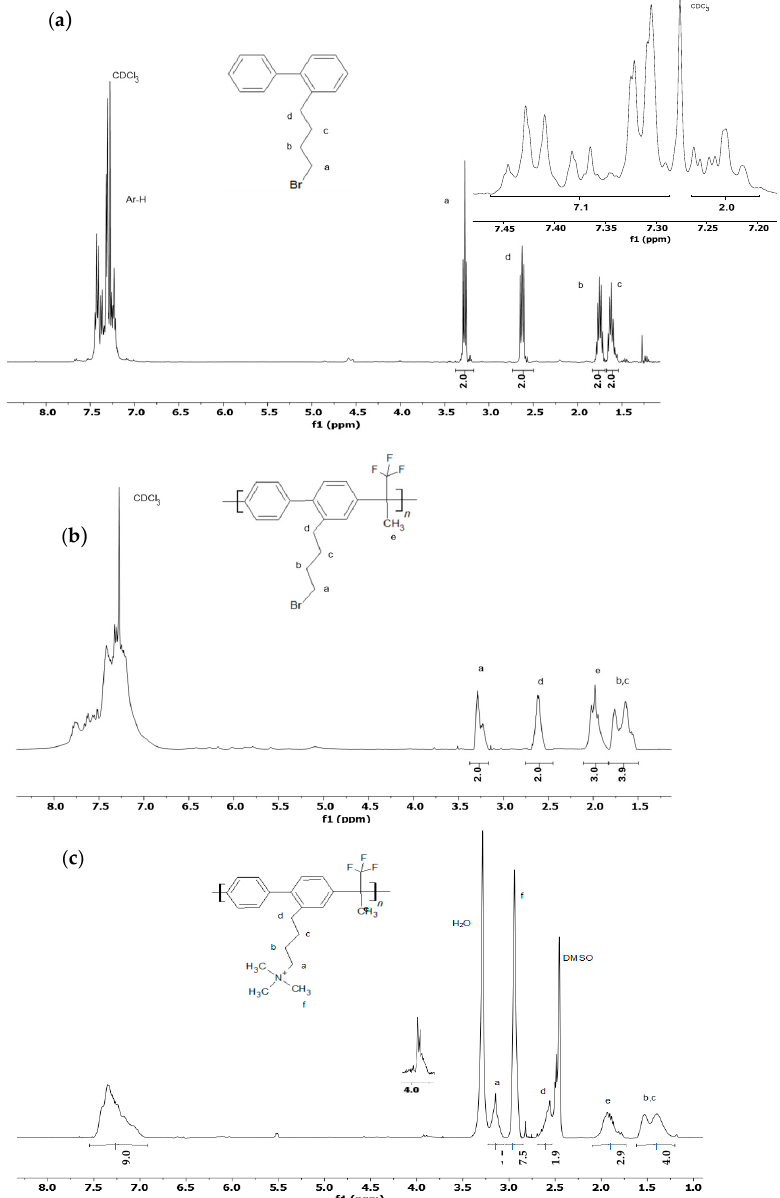
Figure 2. 1 H ‐ NMR analysis of: ( a ) 2 ‐ (4 ‐ bromobutyl)biphenyl ( 2 ) in CDCl 3 ; ( b ) poly[(2 ‐ (4 ‐ bromobu ‐ Figure 2. 1 H-NMR analysis of: ( a ) 2-(4-bromobutyl)biphenyl ( 2 ) in CDCl 3 ; ( b ) poly[(2-(4- tyl)biphenyl ‐ 4,4 ′‐ diyltrifluoromethylmethylmethylene] ( 3 ) in CDCl 3 ; ( c ) PBBAA ( 4 ) in DMSO ‐ d 6 . bromobutyl)biphenyl-4,4 (cid:48) -diyltrifluoromethylmethylmethylene] ( 3 ) in CDCl 3 ; ( c ) PBBAA ( 4 ) in DMSO-d 6 The IEC of the ionomer determined by acid–base titration (IEC = 2.5 meq/g) is in good agreement with the degree of functionalization (DAM) obtained from NMR spectroscopy (IEC 2.4 meq/g), according to the equation: